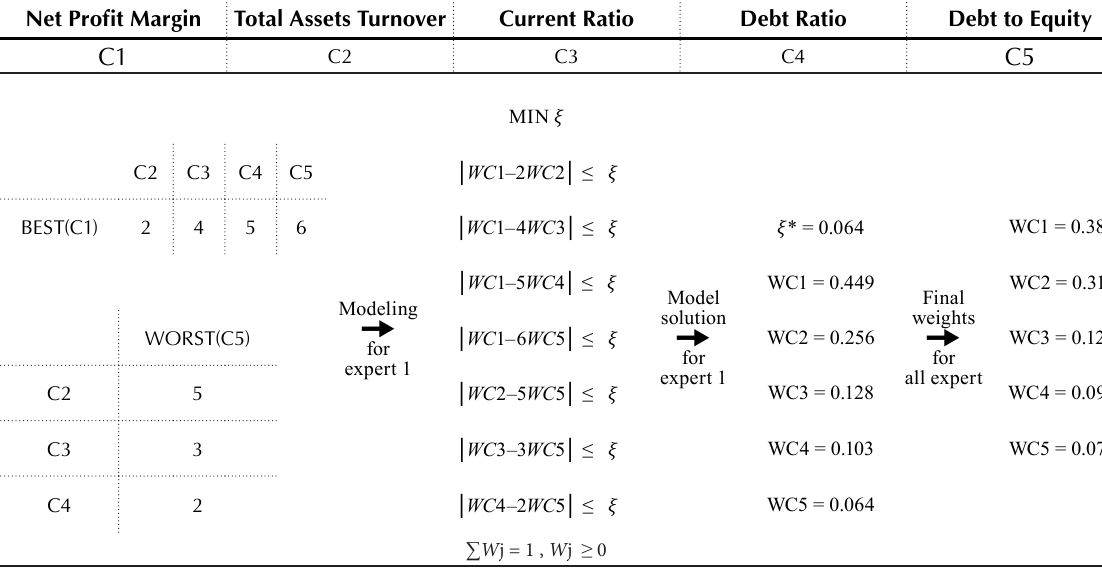
Table 2. Calculating the weight of financial ratios